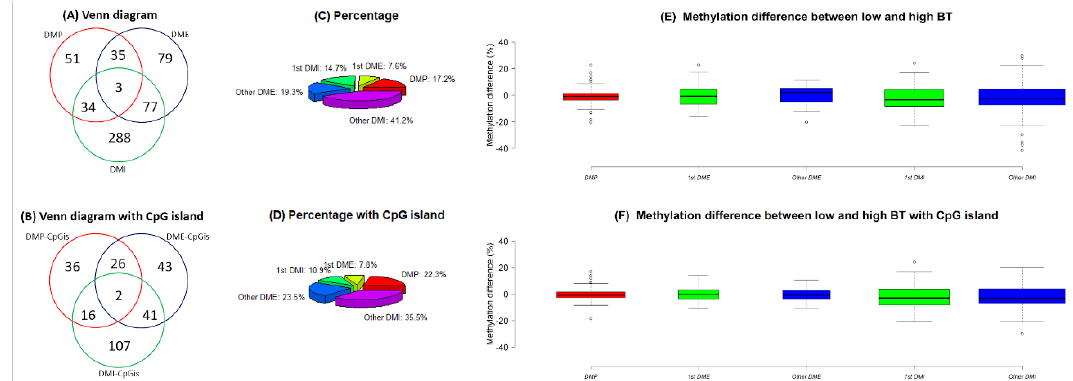
(DMIs). ( C ) Pie charts and ( D ) pie charts with CpG islands of DMPs, and DMEs and DMIs in first and other ordinal positions. ( E ) Boxplots and ( F ) boxplots with CpG islands of methylation di ff erences (%) for DMPs, and DMEs and DMIs in first and other ordinal positions. Note: Methylation di ff erence (%) refers to the di ff erence in methylation levels between the low and high BT groups. The widths of boxplots indicate the proportion to the square root of the number of